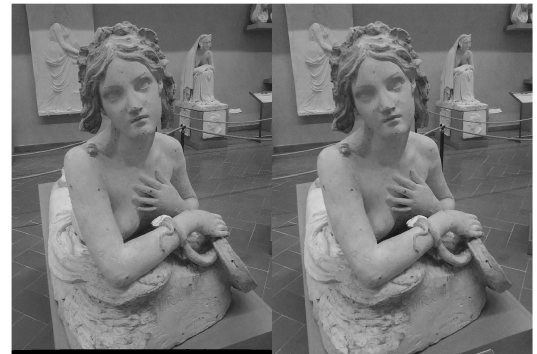
Figure 5. Rectified stereo images (gray-scale).